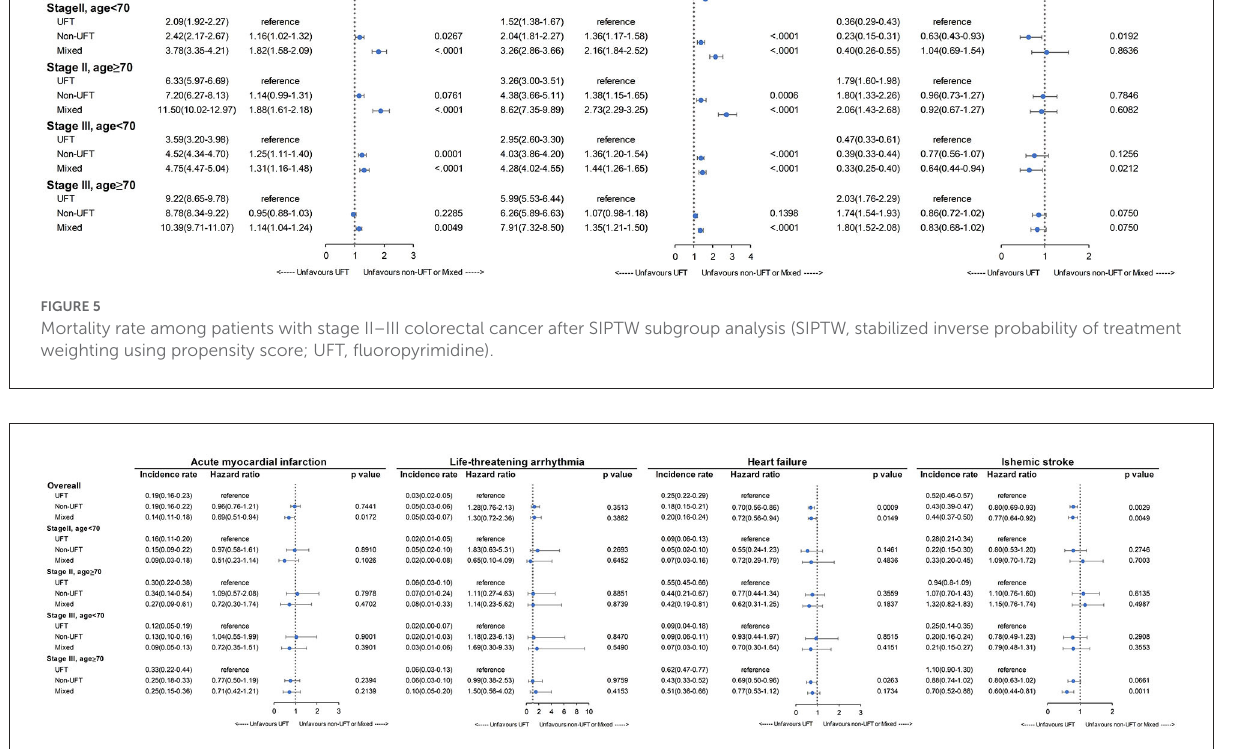
FIGURE6 Incidence rate of cardiovascular outcomes among patients with stage II–III colorectal cancer after SIPTW subgroup analysis (SIPTW, stabilized inverse probability of treatment weighting using propensity score; UFT,